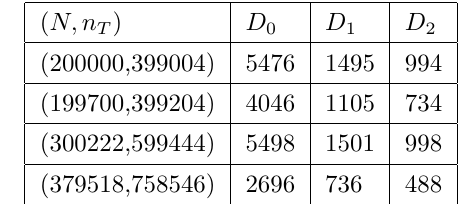
Table 1 . The table presents the degeneracies of energy levels of each spectrum shown in fig- ure 3. We show pairs of parameters N and n T used to compute each spectrum in the first column, while degeneracies of corresponding energy levels are shown in the latter three columns.